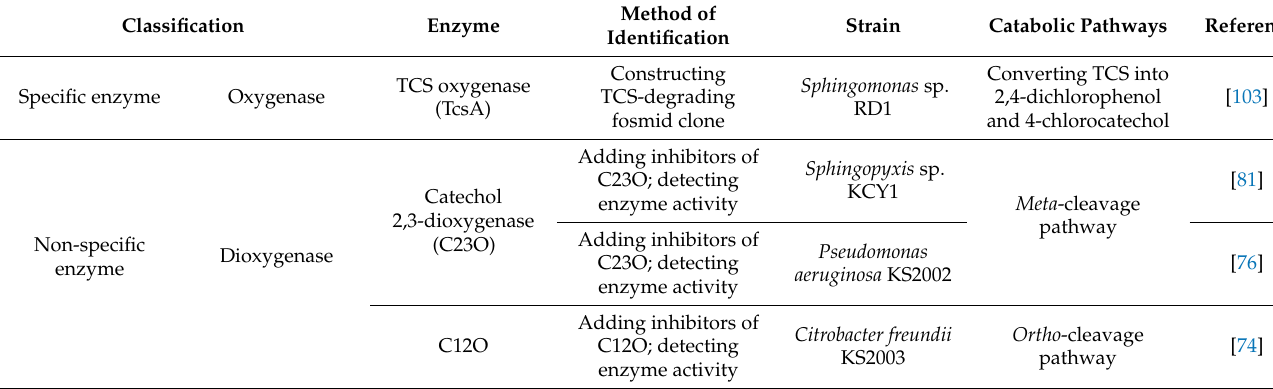
Table 4. Methods to identify the different enzymes involved in TCS